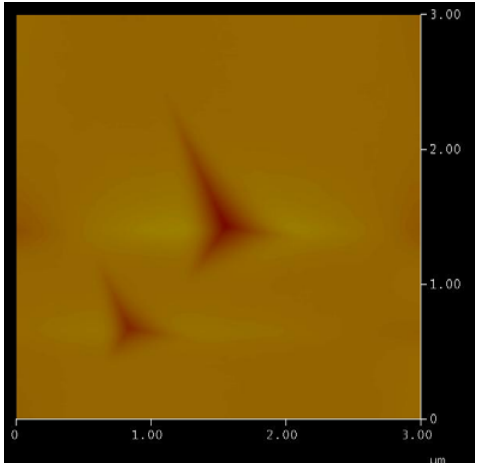
Figure 11. Hardness test using a hysitron nano